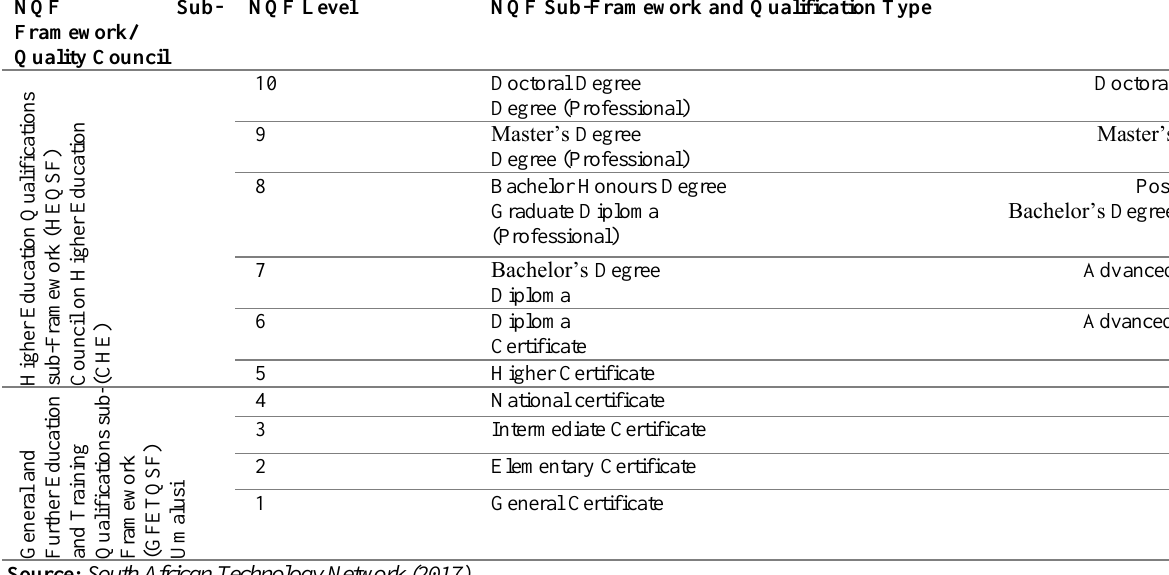
Table 1: National Qualifications Framework for South